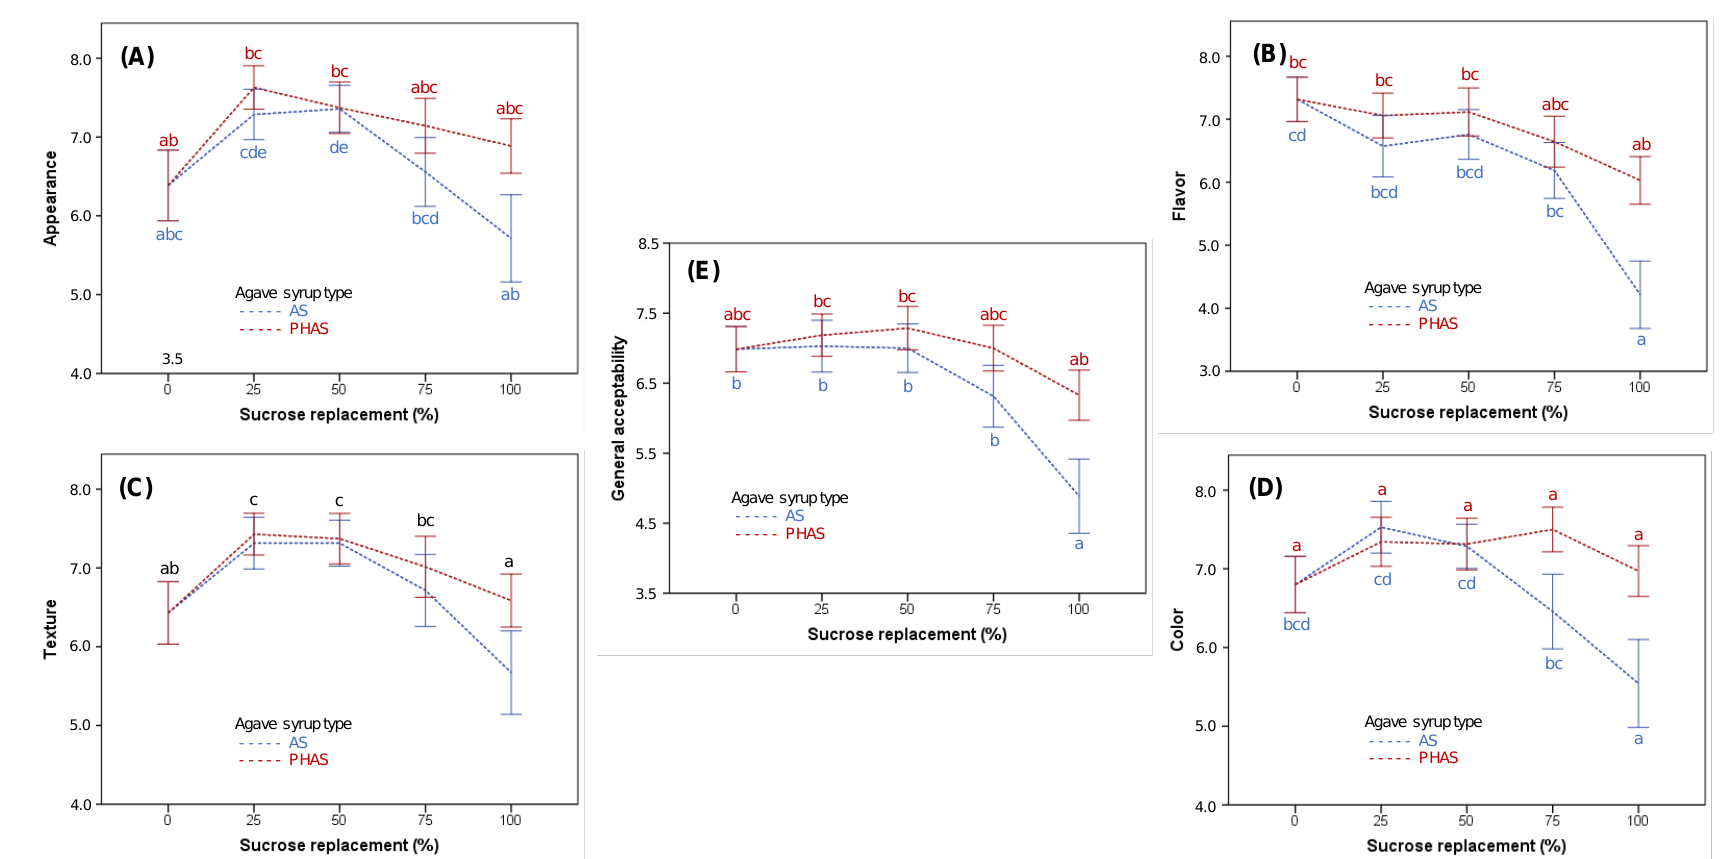
Figure 6. The impact of sucrose replacement by AS and PHAS on sensory properties in muffins, namely appearance ( A ), flavor ( B ), texture ( C ), color ( D ), and general acceptability ( E ). The letters above each data point represent Tukey’s homogenous groups ( p < 0.05) calculated for the sucrose replacement factor. Error bars represent 95% confidence interval. The different subscript letters of the same color represent Tukey’s homogeneous groups, with significant ( p < 0.05) differences between different sucrose replacement levels for AS (blue letters), PHAS (red letters), or for both types of agave syrup when there was no interaction between sucrose replacement and agave syrup type (black letters).